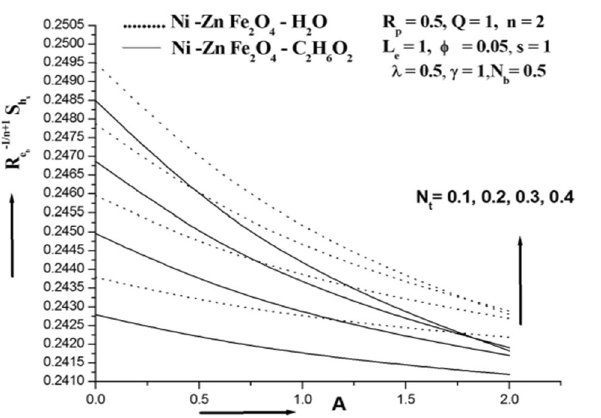
Figure 7. Sherwood number for various N t .